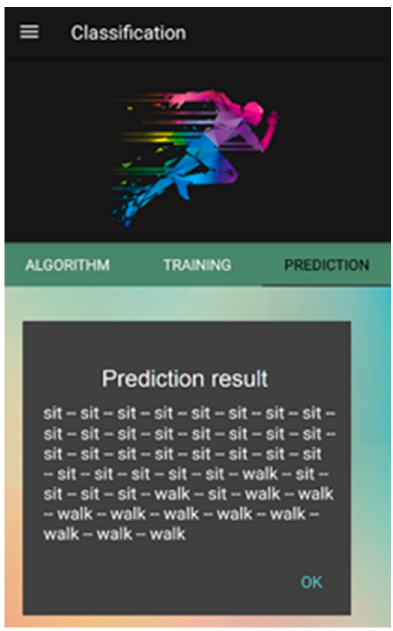
Figure 8. Misrecognition of a sit-to-stand transition in our preceding data-driven approach.